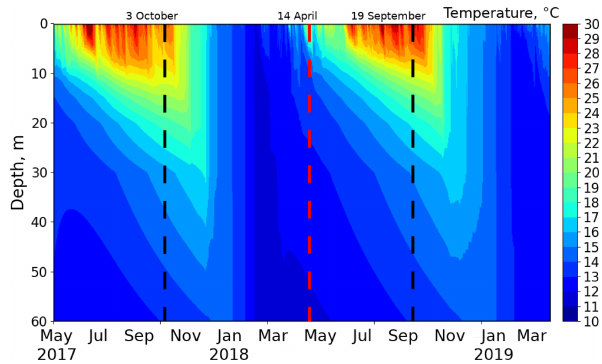
Figure 2. Time–depth Hovmöller diagram of the LAKE 2.0 sim- ulated water temperature in the Alqueva reservoir based on hourly data. Dashed lines indicate the end (black) and the beginning (red) of